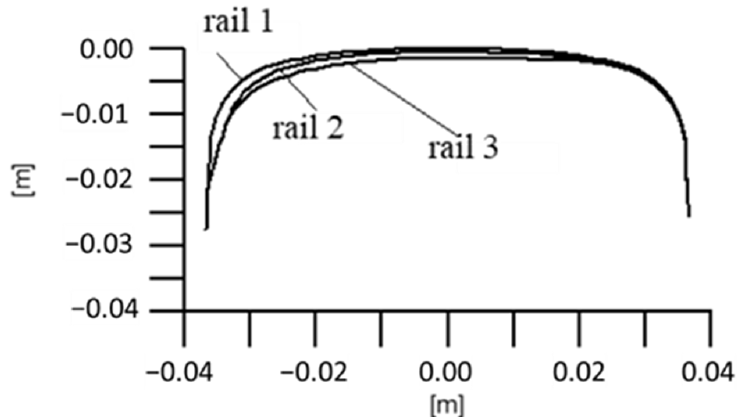
Figure 17. The rails profiles adopted in the simulation